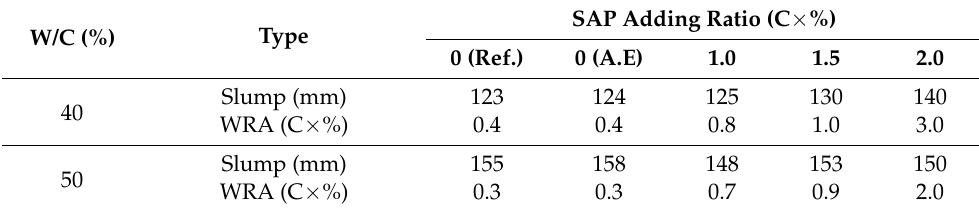
Table 6. Slump value according to adding of